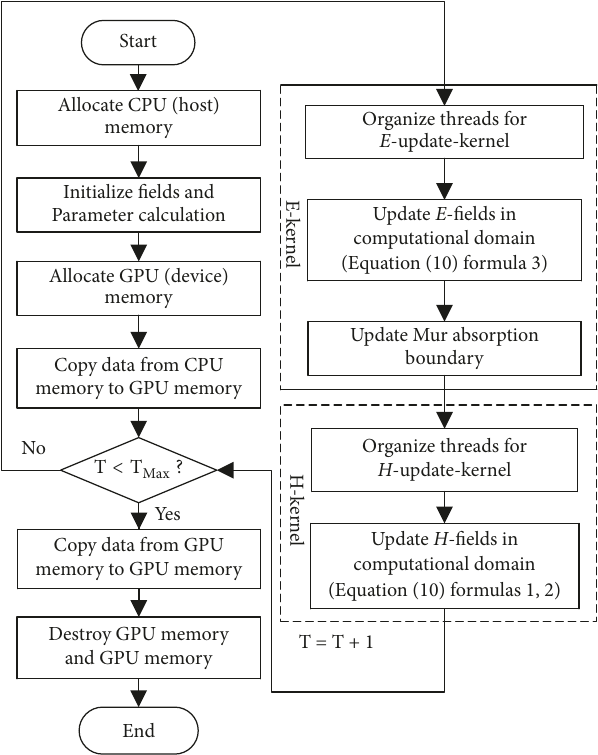
Figure 6: The flowchart of the CUDA-implemented FDTD